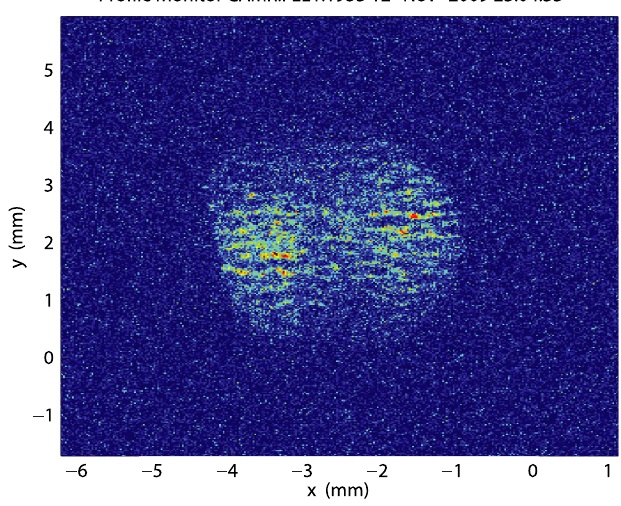
FIG. 7. An example image in the soft x-ray beam line (P3S1) shows the characteristic double lobe structure of the second harmonic. Though gas and solid (beryllium) attenuators strongly suppress the fundamental in this image, a small amount of fundamental radiation remains (Gaussian mode background). speckle pattern.